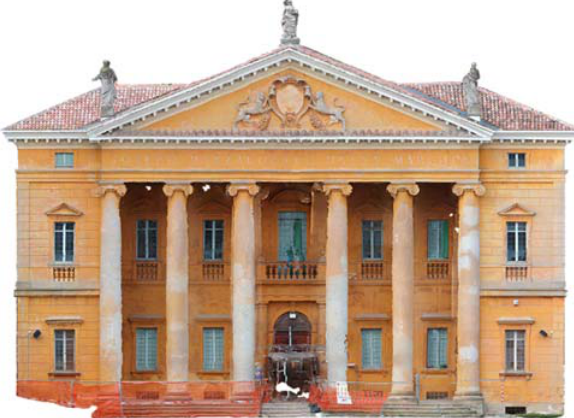
Figure 8. Ortho-mosaic of the building façade.